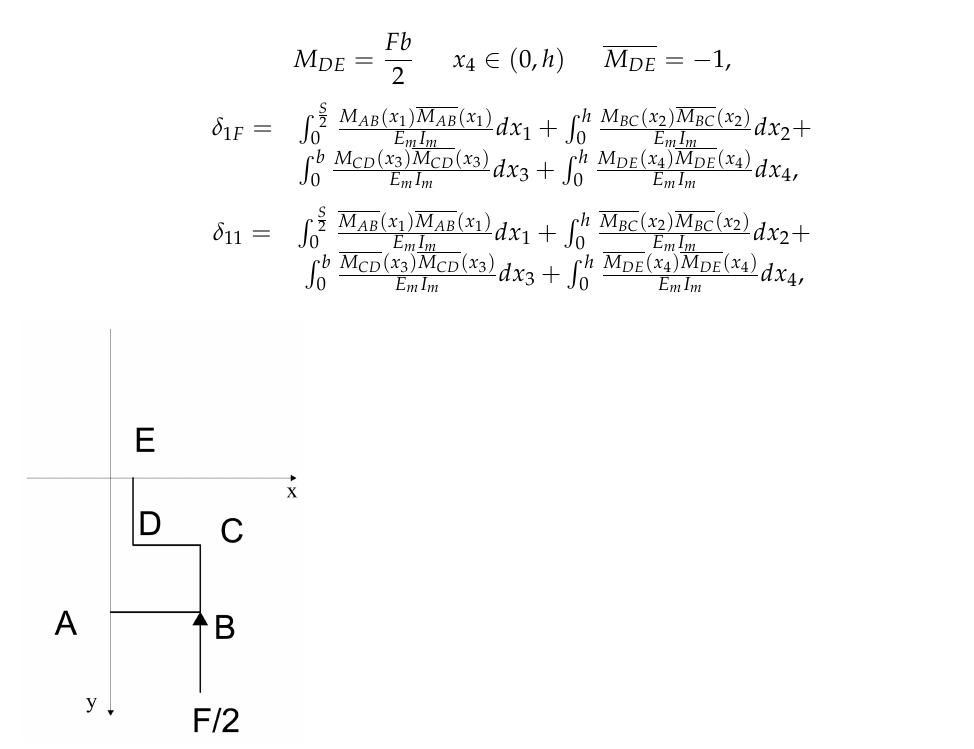
Figure 4. One-fourth structure when only F /2 load is applied.